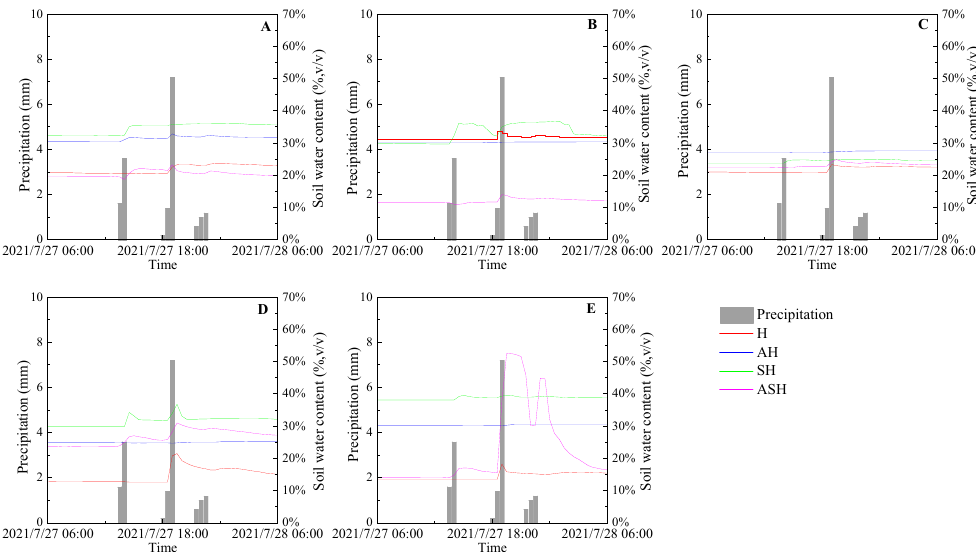
Figure 6. The variations of soil moisture content at moderate rain event. ( A ) 0–10 cm, ( B ) 10–20 cm, ( C ) 20–30 cm, ( D ) 30–50 cm, ( E ) 50–70